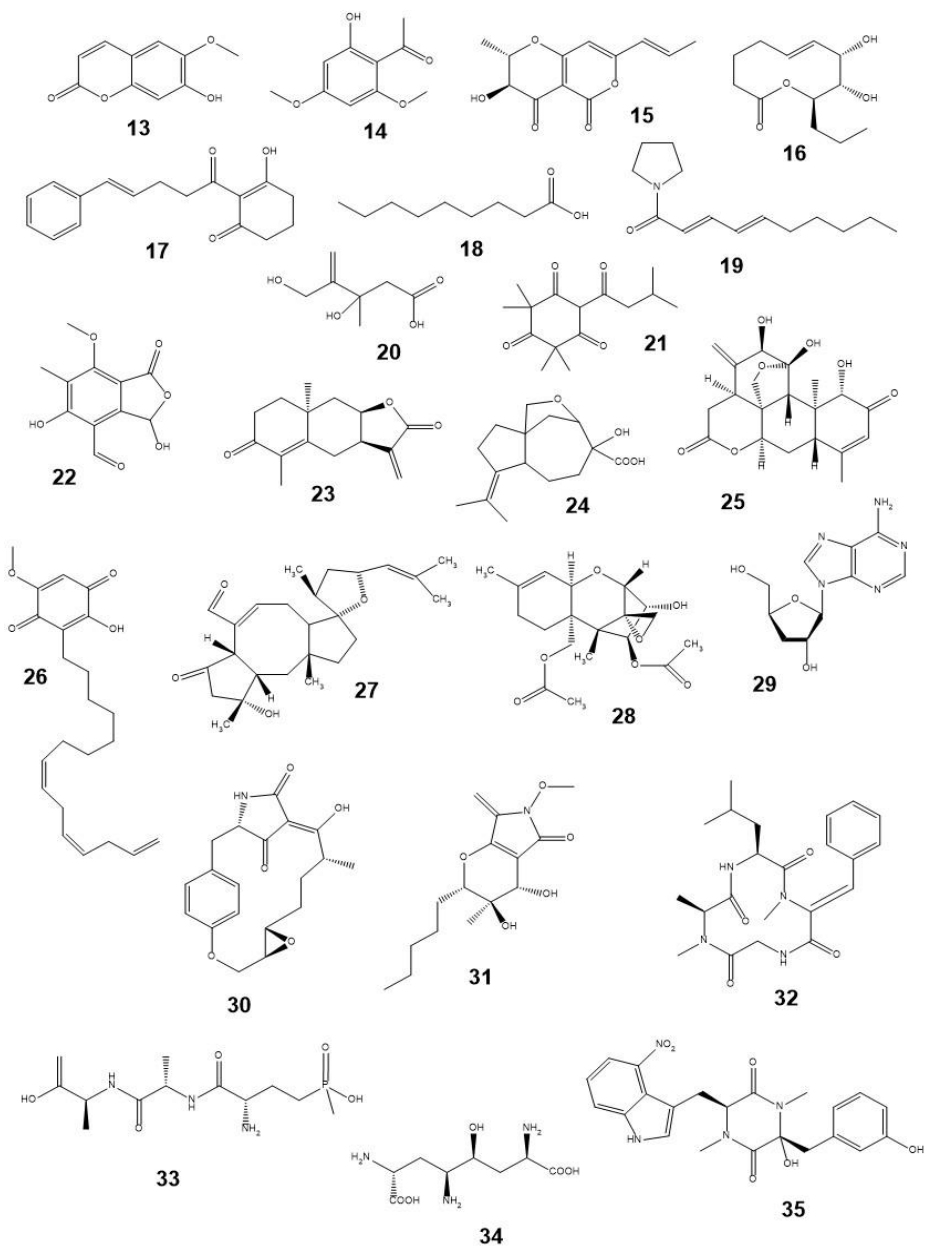
Figure 3. Structures of phytotoxins mentioned in the text: 13 — scopoletin, 14 — xanthoxyline, 15